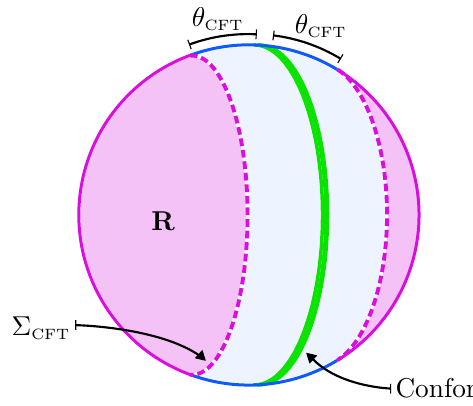
Figure 5 . A timeslice of our CFT setup. A conformal defect running along the equator separates the two halves of R and its corresponding engangling surface (cid:6)